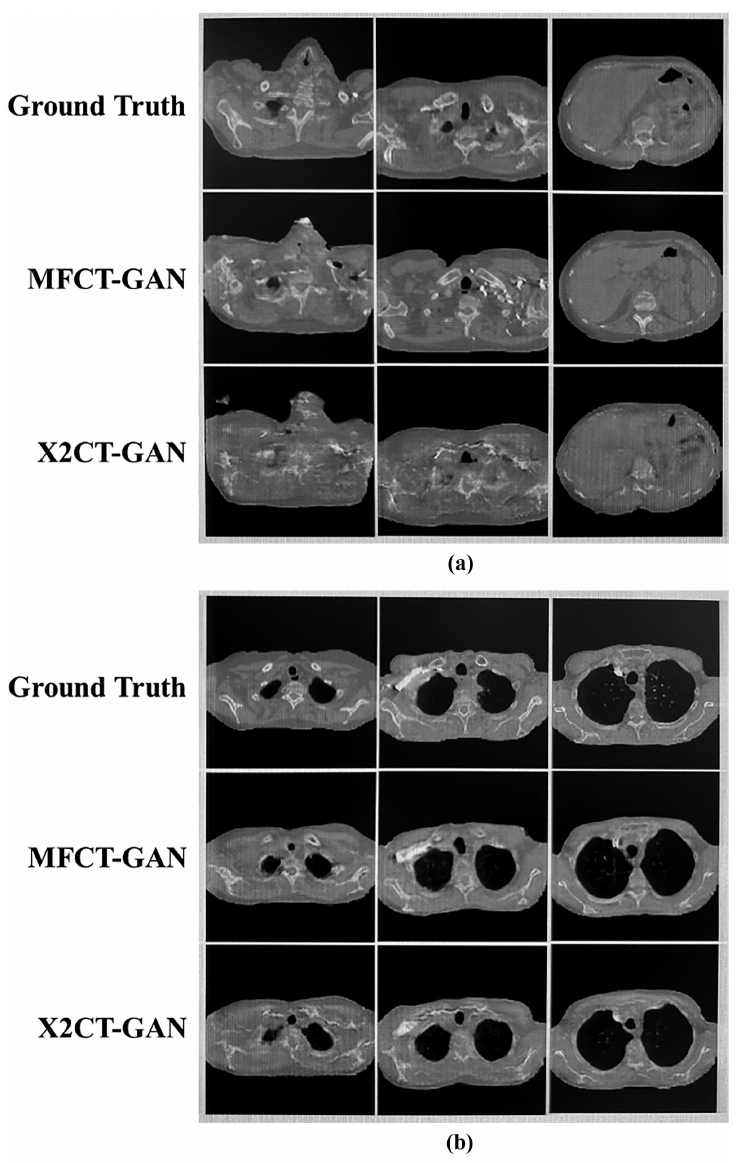
Figure 3. Comparison of the reconstruction results of the two